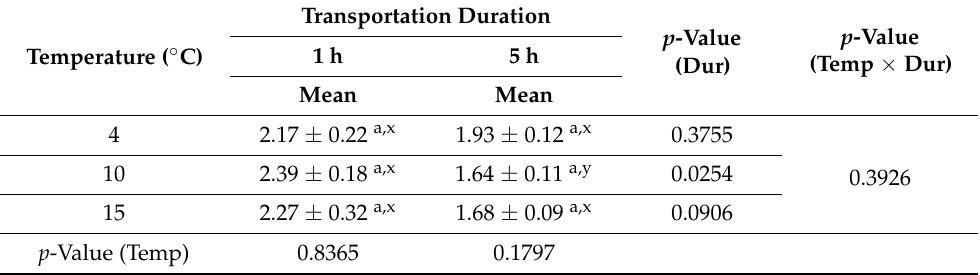
Table 1. Effects of transportation temperatures (4 ◦ C, 10 ◦ C, and 15 ◦ C) for two different transportation durations (1 and 5 h) on drip loss (%) of the pectoralis major muscles in broiler chickens.